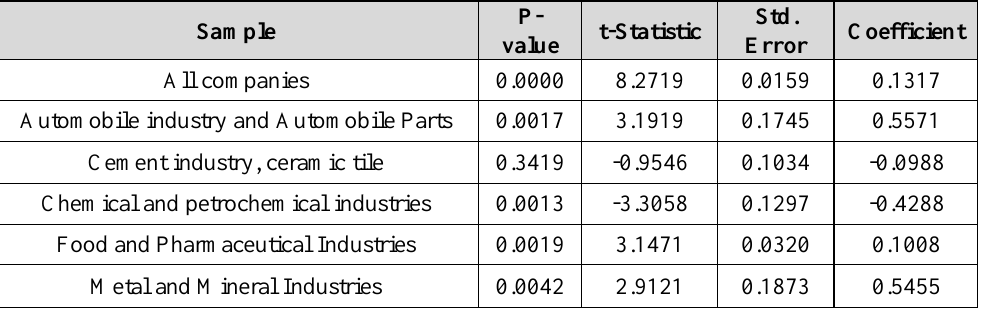
Table 8. Results of the Decline stage and capital investment choice in the type of